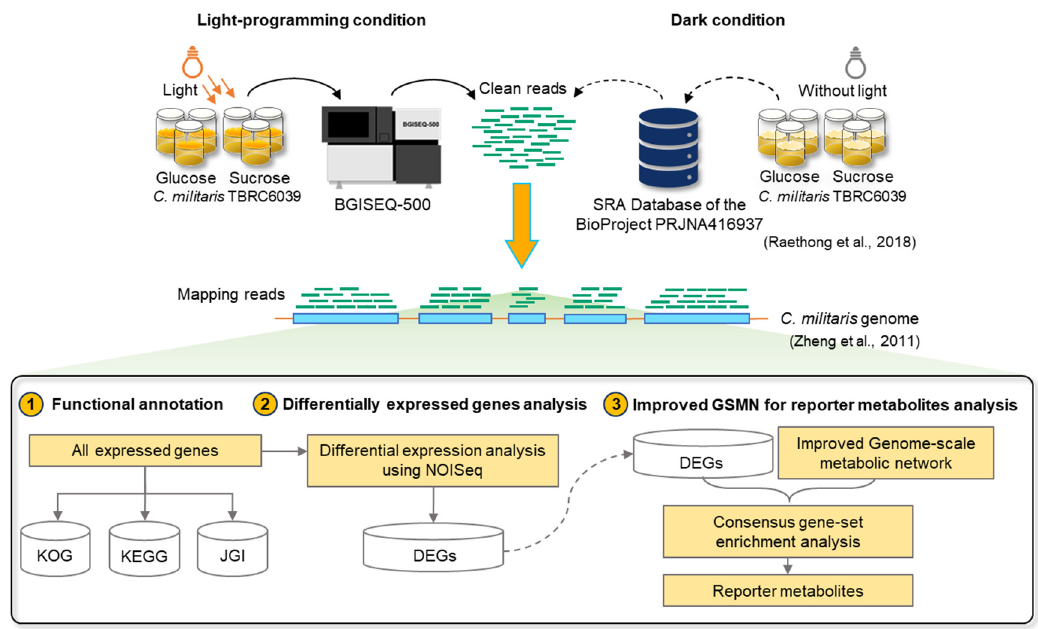
Figure 1. Systematic workflow of transcriptome analysis and genome-scale metabolic network-driven analysis of C. militaris strain TBRC6039.